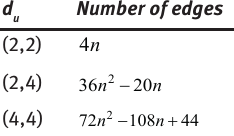
Table 7: Edge partition of D